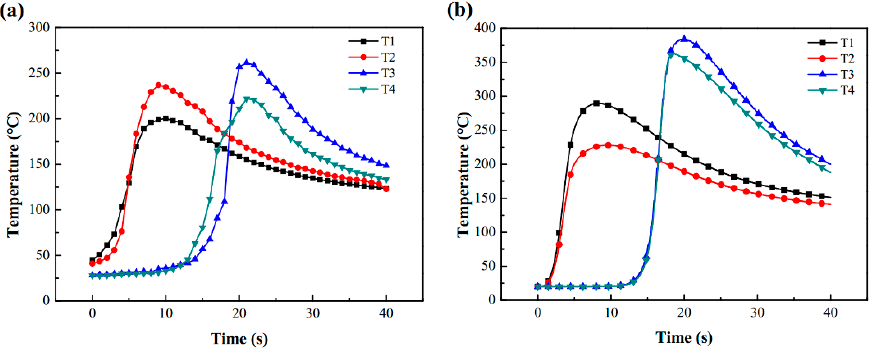
Figure 8. Thermal cycle diagrams for sample 1#: ( a ) measurement temperature; ( b ) simulation